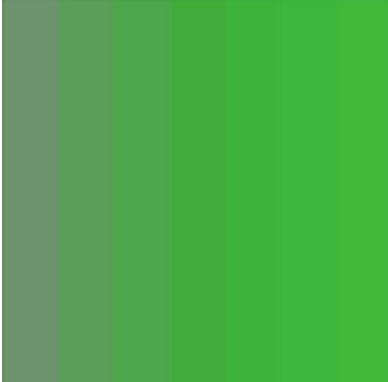
Figure 1: The equal di ff erence of saturation test ladder